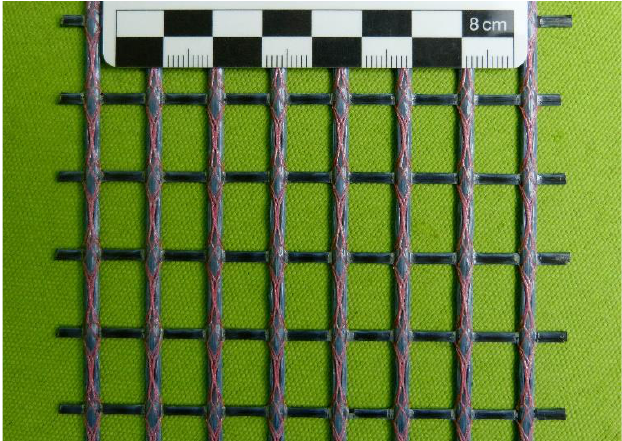
Figure 1. Carbon textile with a mesh size of 12.7 mm × 16 mm (© Markus